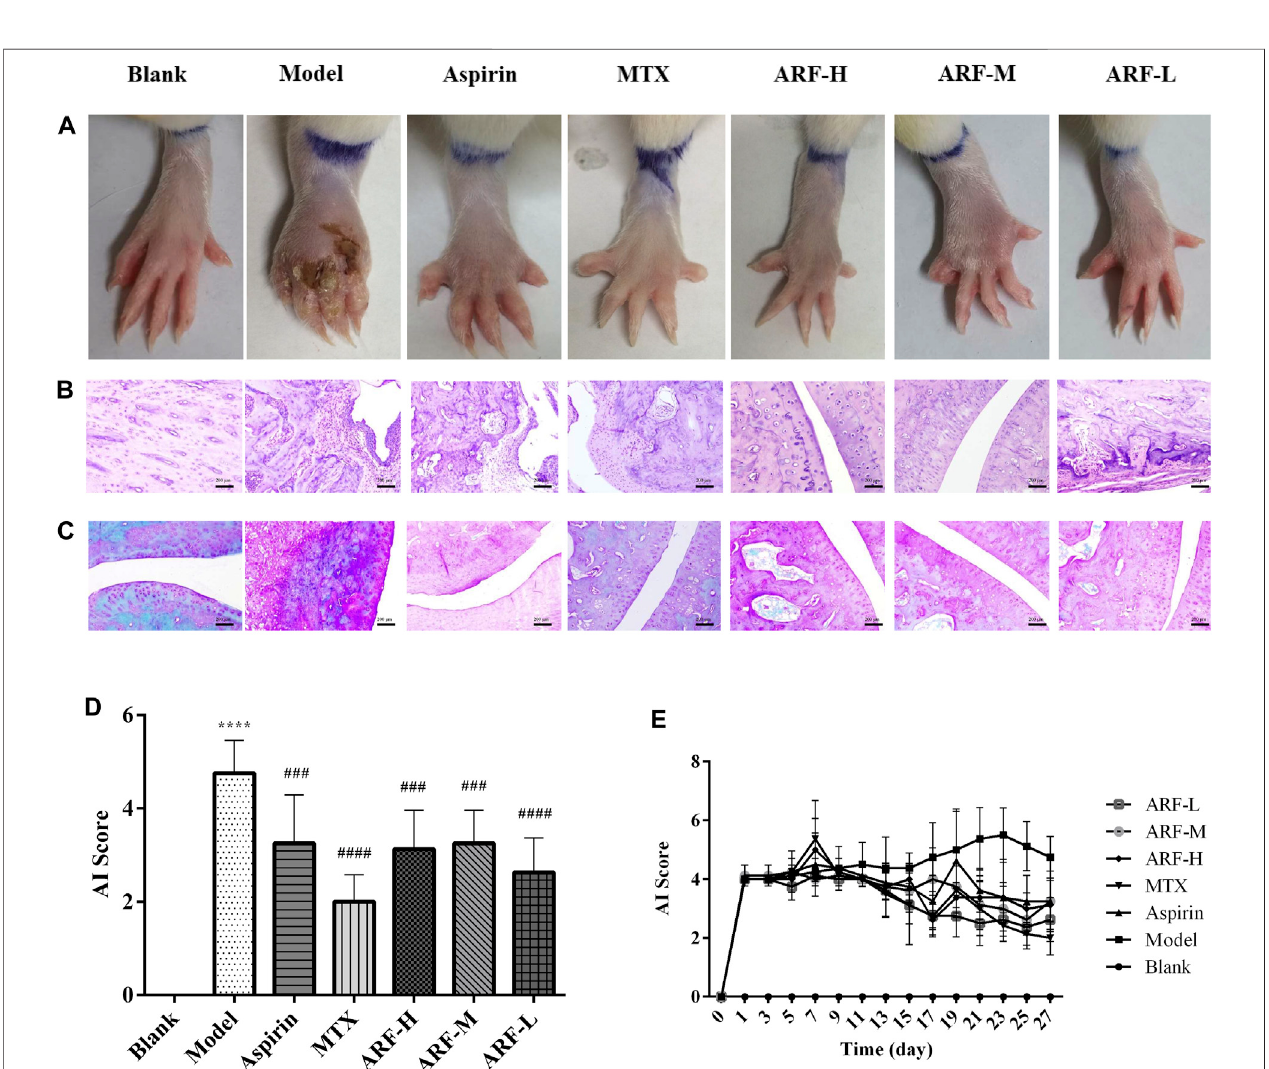
FIGURE 3 | Effect of orally administered ARF on morphological changes and histologic lesions in AIA rats. (A) External manifestation of AIA rats on day 27 after immunization, erosion, and red swelling in the paws apparently ameliorated in the ARF-treated group. (B) Histological survey of the joints in rats (H&E staining). Original magni fi cation × 100. (C) ResultsofSafranin-O – FastGreenstainingincartilageofjoints.Originalmagni fi cation × 100. (D,E) AIscoresinjointsonday27andoneveryother day, ashasbeen described inthe Materials and Methods section, respectively. Dataareexpressed asmean ± SD ( n (cid:1) 8). Comparison withtheBlankgroup, **** p < 0.001. Comparison with the Model group, ### p < 0.005, #### p < 0.001.